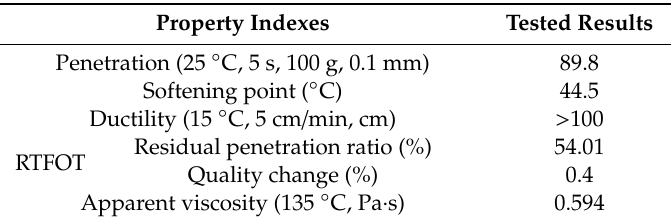
Table 1. Basic property indexes of base asphalt.